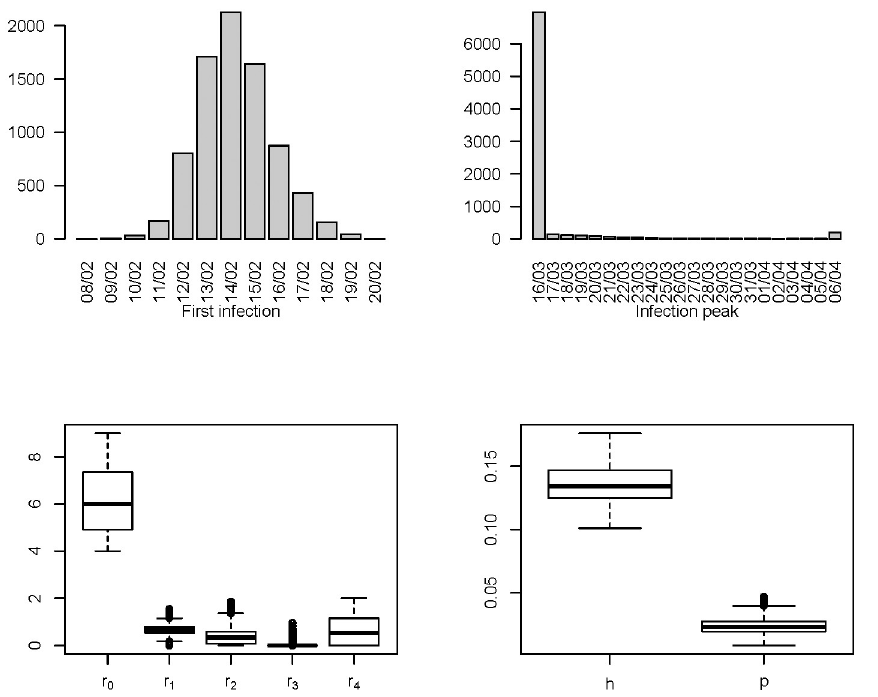
Fig 6. Distributions of the model outputs as the inputs